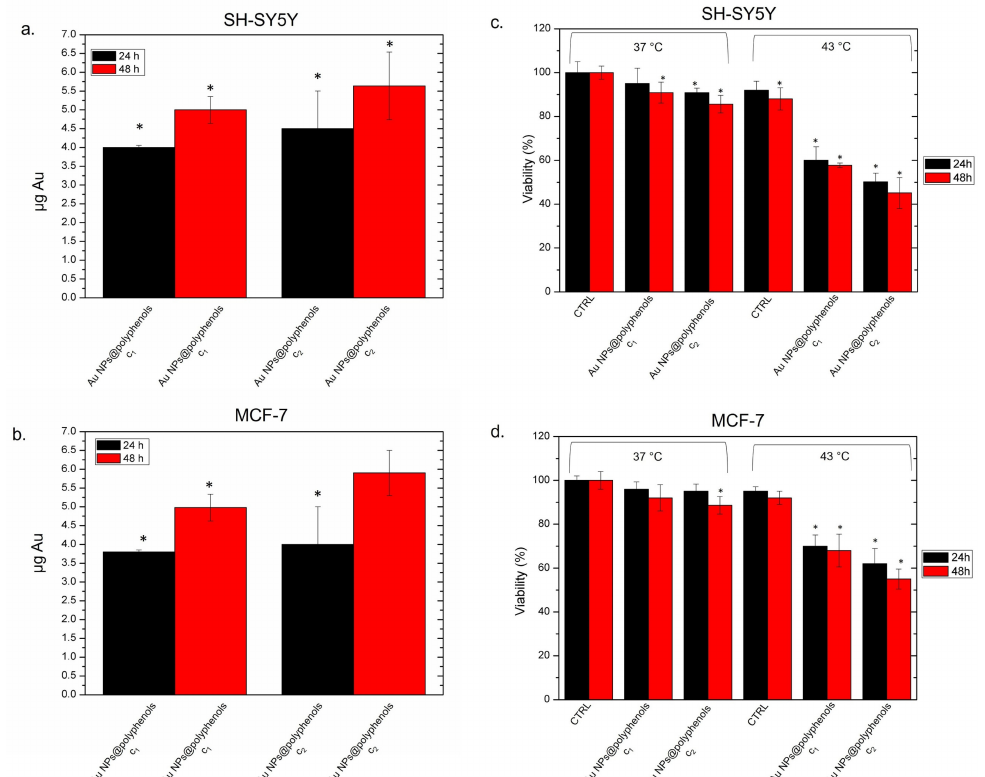
Figure 6. Accumulation in SH-SY5Y ( a ) and MCF-7 ( b ) cell lines exposed to the c1 and c2 of Au NPs@polyphenols for 24 h and 48 h. The cells were then harvested, the live cells were counted, and the Au content was measured in 360,000 cells ( µ g Au). The data are reported as the mean ± SD from three independent experiments, and statistically significantly exposed cells vs. control cells have a p value < 0.05 (<0.05 *). The viability assay (WST-8) of the SH-SY5Y ( c ) and MCF-7 cell lines ( d ) after 24 h and 48 h of exposure to two doses (c1 and c2) of Au NPs@polyphenols at 37 ◦ C and 43 ◦ C, following the procedure described in the section, Materials (ph. 2.10). The viability of NP-treated cells was normalized to non-treated control cells. As a positive control (P), the cells were incubated with 5% DMSO (data not shown). The data reported as the mean ± SD from three independent experiments are considered statistically significant, compared with the control ( n = 8), with a p value < 0.05 (<0.05